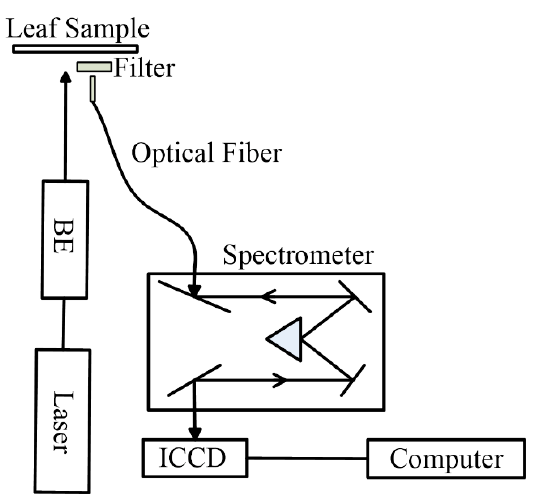
Figure 2. The schematic of the LIF system. BE, beam expander (5 times at 355 nm, 460 nm and 556 nm); ICCD, intensified charge-coupled device.